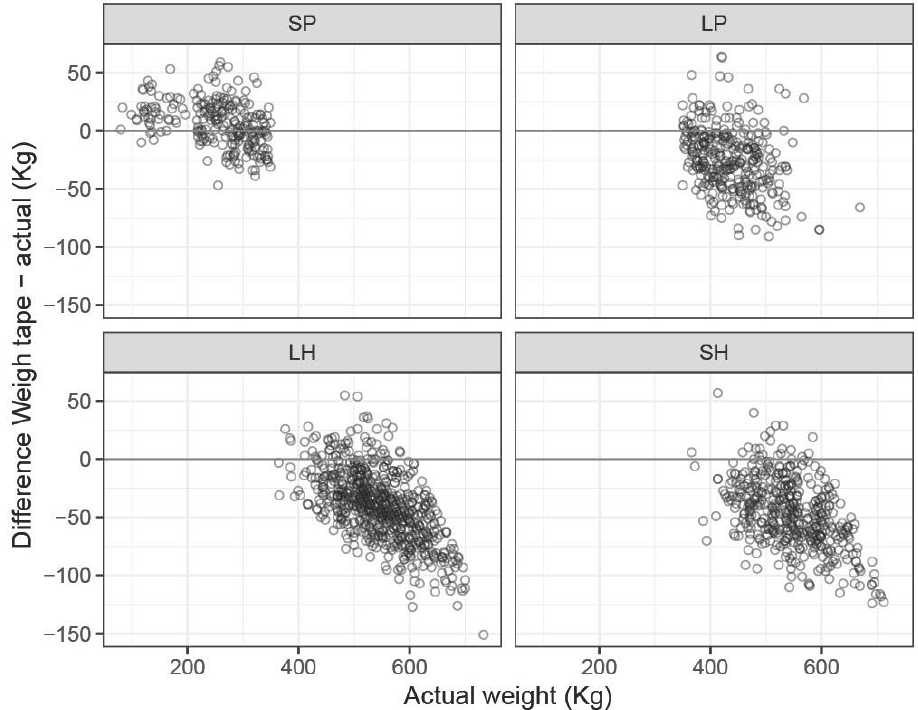
Figure 5. The relationship of the difference between the weigh tape and actual weights, compared to the actual weights, separated into four breed categories [14], which were: small ponies under 350 kg (SP); large ponies more than 350 kg but under 14.2 hh/147 cm (LP); lighter builds of horses such as thoroughbreds (LH); and stockier breeds of horses such as drafts